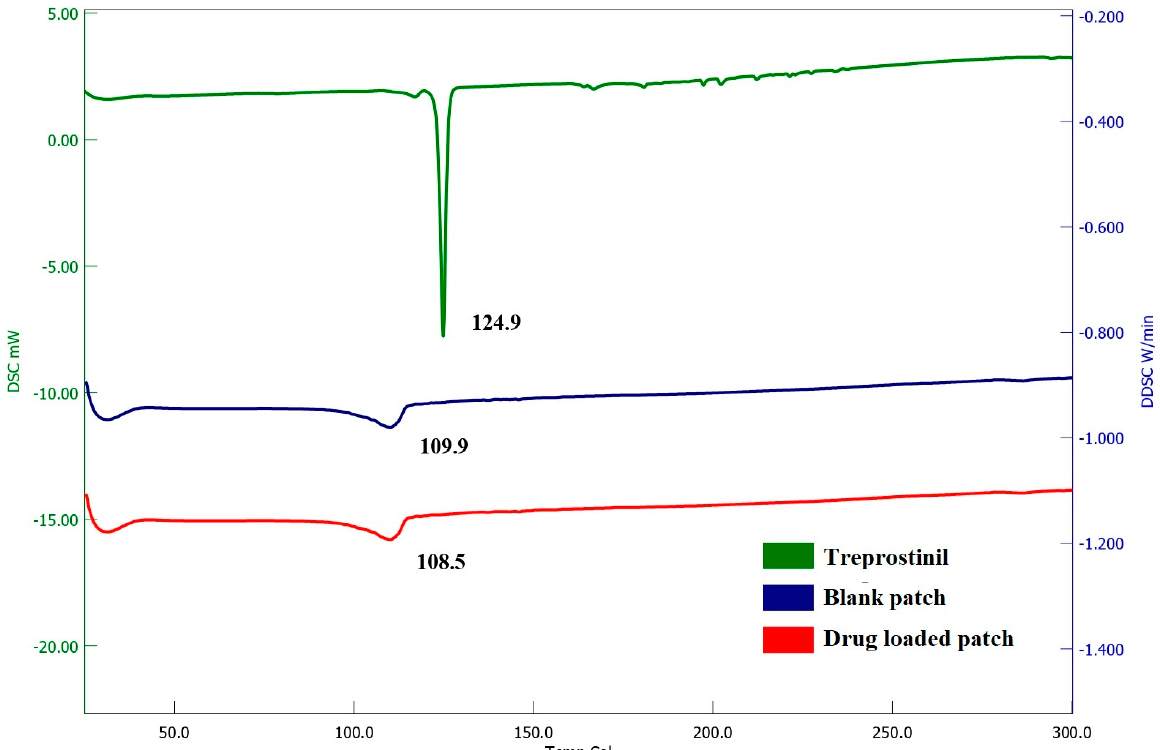
Figure 11. Differential scanning calorimetry thermograms of treprostinil, blank patch, and optimized drug-loaded patch.